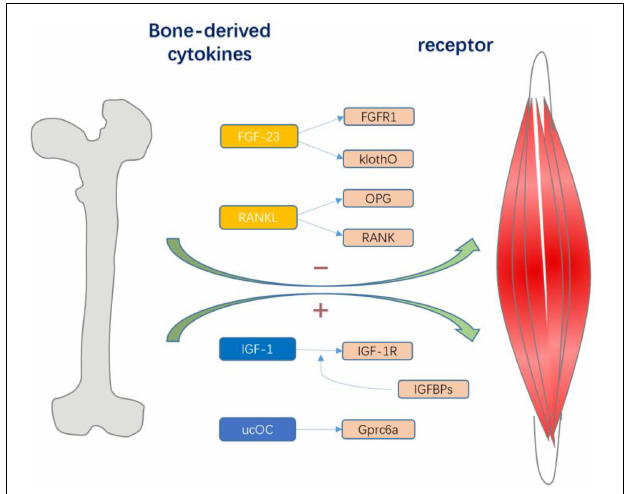
FIGURE 2 | Various bone cells can secrete different bone-derived factors. Osteocalcin regulates exercise through Gprc6a signal transduction in muscle fibers, which also contributes to the nutrient absorption and catabolism of muscles during exercise; and IGF-1 acts on IGF-1R to activate downstream signaling pathways and determines its biological activity. IGFBPs sterically hindered the interaction of IGFs with the IGF-I receptor, and they were potent competitive inhibitors. Both thus have a positive effect on skeletal muscle. And FGF23 and RANKL can have a negative effect on skeletal muscle. The combination of FGF23 with FGFR1 and the co-receptor Klotho stimulates downstream effects, and the RANKL/RANK interaction activates NF-kB, and OPG, as a soluble receptor of RANKL, prevents it from binding to